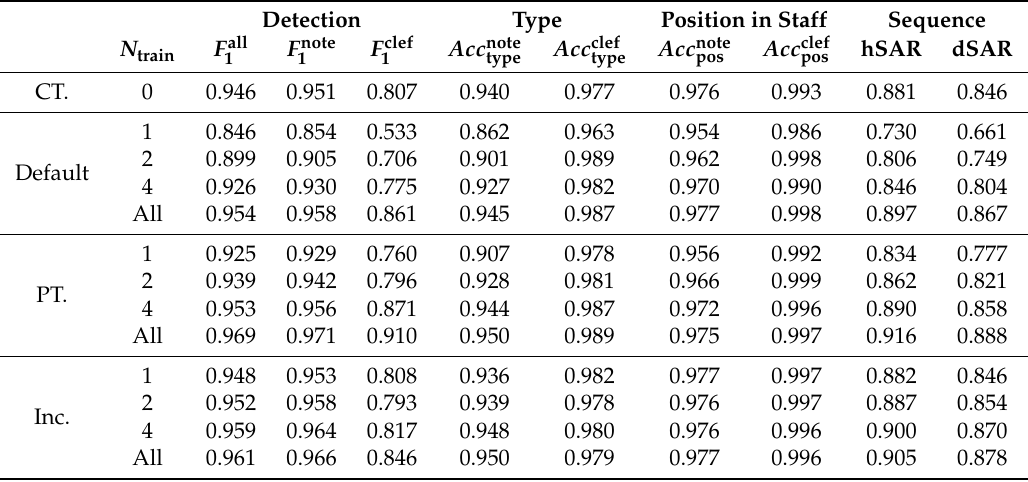
Table 8. Symbol detection scores when varying the number of training examples. The first line is the average of the cross-part training (CT.) experiment of Table 7 where no pages of the target part are used. The next rows (Default) only use N train of the target data set for training. Afterwards, a pretrained model is used (PT.) or the additional part data is included